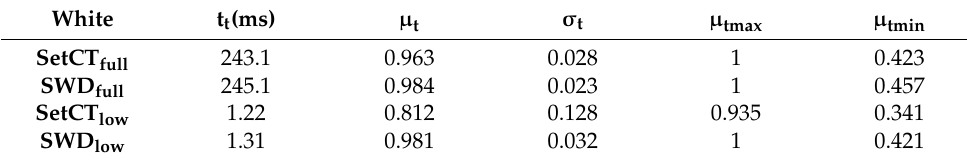
Table 5. Performance evaluation of the THz-FDS classification of a white sample.